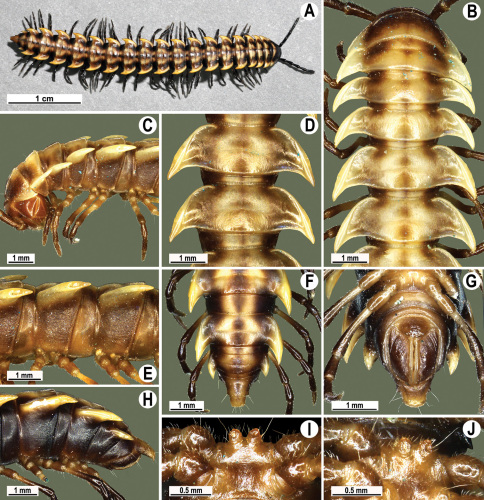
Orthomorpha holorogiformis Golovatch, 1998, ♂ from Phung Chang Cave (A), ♂ from Khao Chao Priest Residence (B–J). A habitus, live coloration B, C anterior part of body, dorsal and lateral views, respectively D, E segments 10 and 11, dorsal and lateral views, respectively F, G, H posterior part of body, dorsal, ventral and lateral views, respectively I, J sternal cones between coxae 4, subcaudal and sublateral views, respectively.